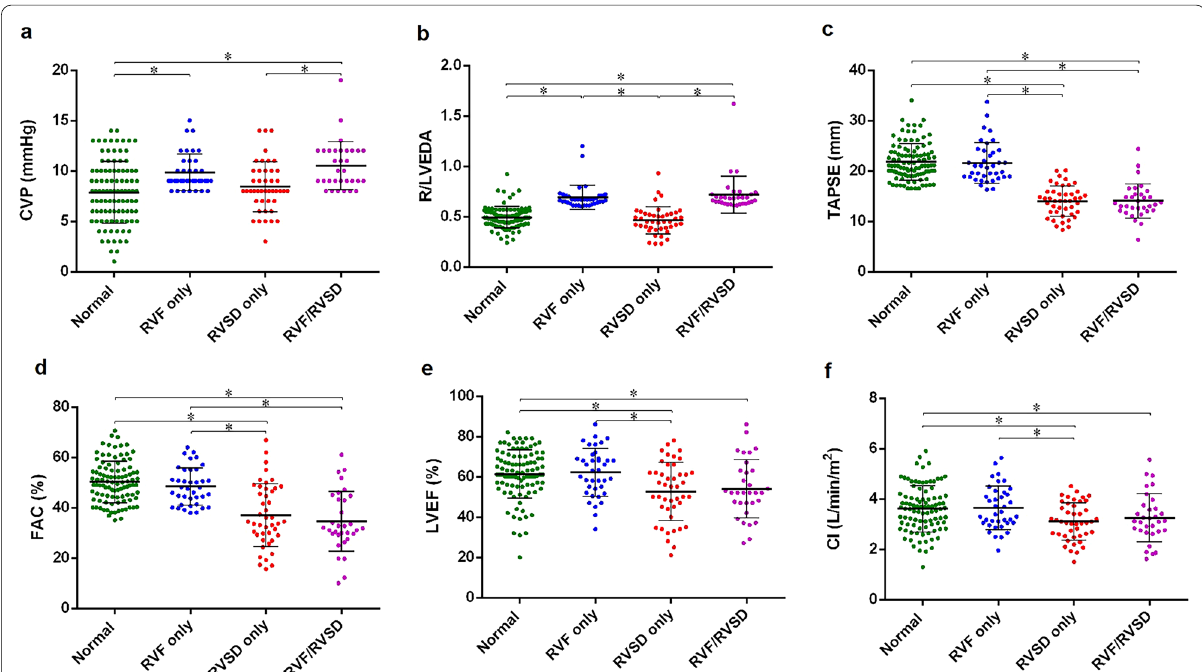
Fig. 2 Haemodynamic and echocardiographic parameters in four groups. a RVF/RVSD group had higher CVP than RVSD only group and normal group ( p < 0.005). RVF only group had higher CVP than normal group ( p < 0.005). b RVF/RVSD group and RVF only group had higher R/LVEDA ratio than RVSD only group and normal group ( p < 0.05). c RVF/RVSD group and RVSD only group had lower TAPSE than RVF only group and normal group ( p < 0.05). d RVF/RVSD group and RVSD only group had lower FAC than RVF only group and normal group ( p < 0.05). e RVF/RVSD group and RVSD only group had lower LVEF than normal group ( p < 0.05). f RVF/RVSD group and RVSD only group had lower CI than RVF only group and normal group ( p <